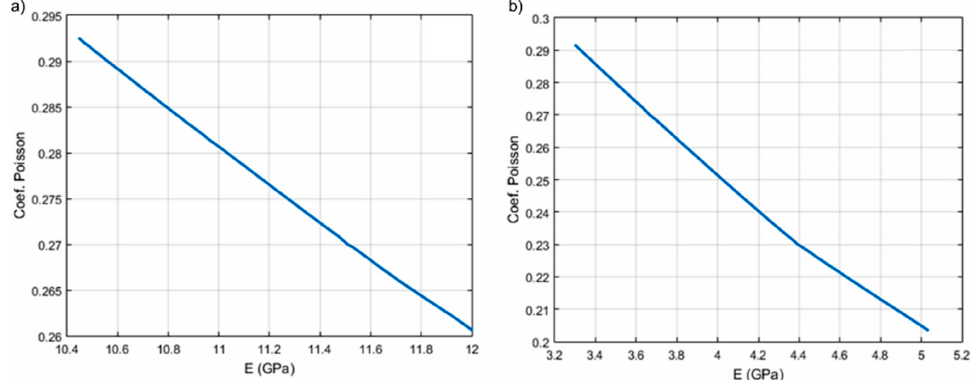
Figure 11. The dependence of Poisson coefficients ( ν ) and the Young (E) modulus for HAp ( a ) and 7ZnHAp ( b ).